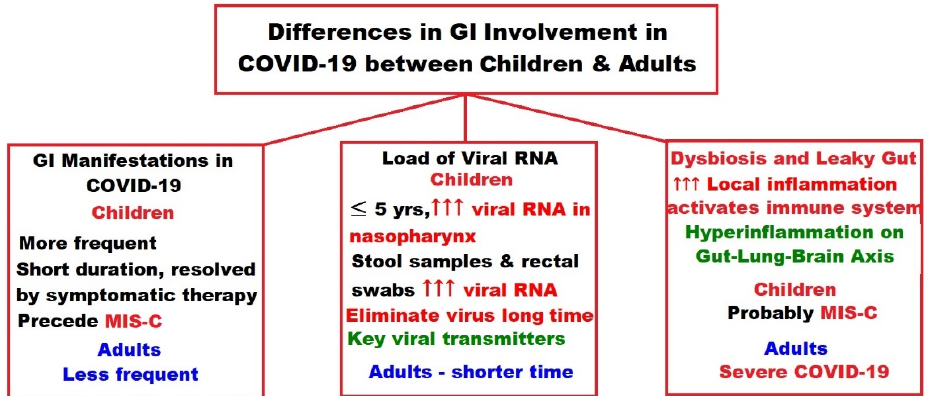
Figure 1. Comparative representation of children—adults of gastrointestinal involvement in COVID-19. Legend: ↑↑↑ = “Very high”.